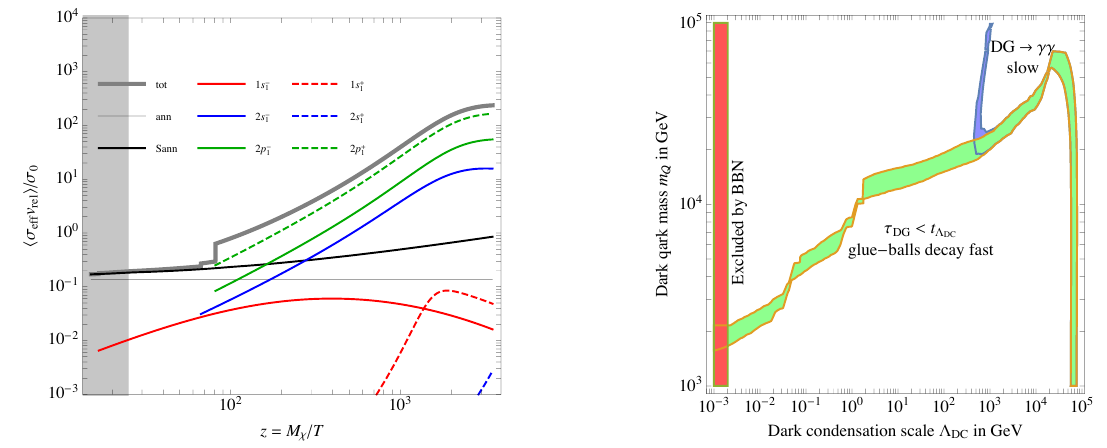
Figure 13 . Model with G DC = SU(3) and with a dark quark tripled under SU(2) L . averaged cross sections for annihilation and for bound states formation, assuming m and (cid:11) = 0 : 07 ((cid:3) DC 3 GeV). Right: region where dark baryons reproduce the DM cosmological DC (cid:25)